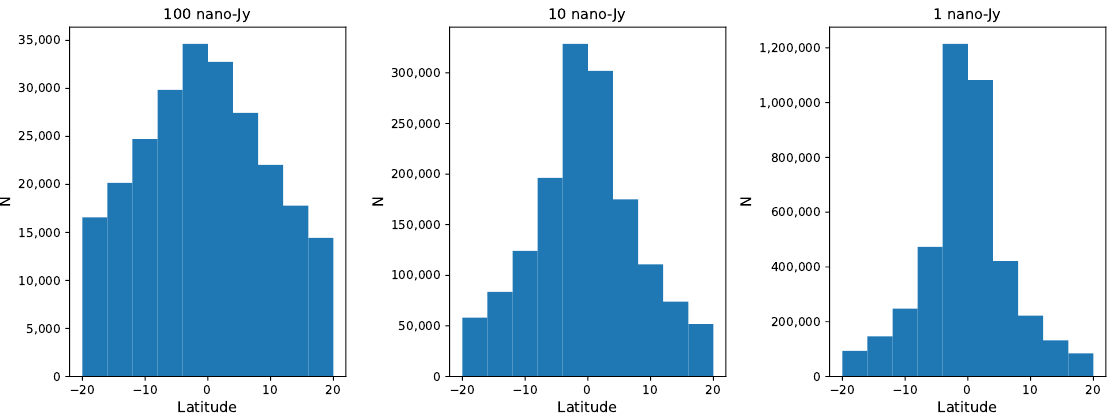
Figure 10. The latitude distribution of M dwarf flares above different 8-hour detection limits (100 nano-Jy, 10 nano-Jy, and 1 nano-Jy), where the flare is assumed to last for 20 min.